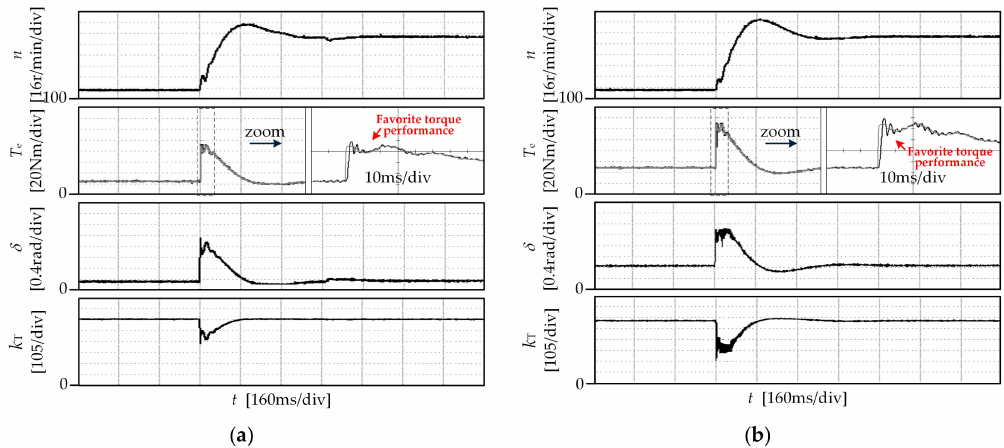
Figure 14. Experimental waveforms of the improved and conventional DTC-SVM scheme during transient operation. ( a ) No load; ( b ) 50 Nm load.